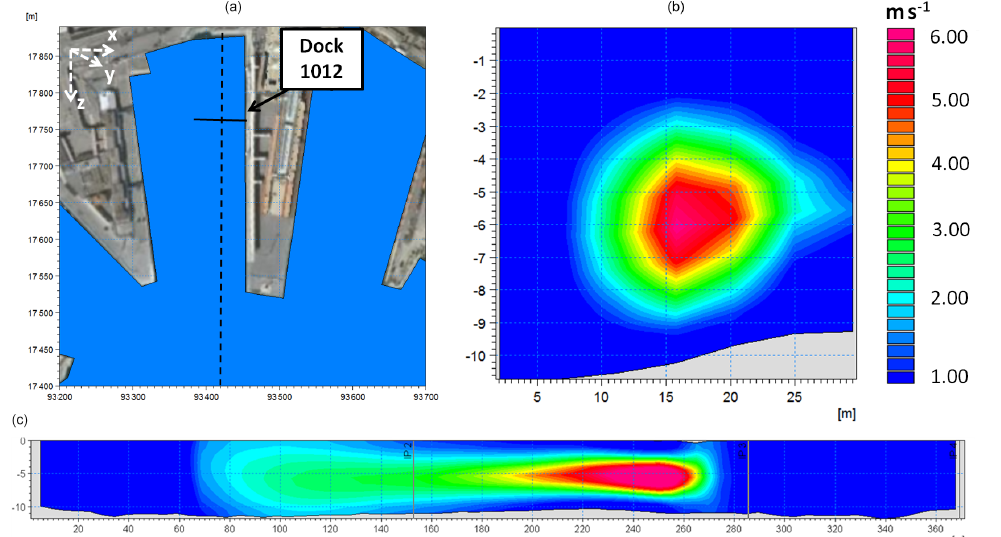
Figure 5. Representation of the propeller-induced jet of the most representative ship departing from dock 1012. (a) Plan view of the ship’s departure: the dashed line represents the trajectory followed by the axis of the undocking ship, and the solid line represents the position of the vertical transect shown in panel (b) . (b) Vertical transect showing the jet-induced velocity in the xz plane (propeller’s plane). (c) Transect of velocity along the propeller’s axis ( yz plane). Velocities are in meters per second (ms − 1 ). Land background from © Google Earth.